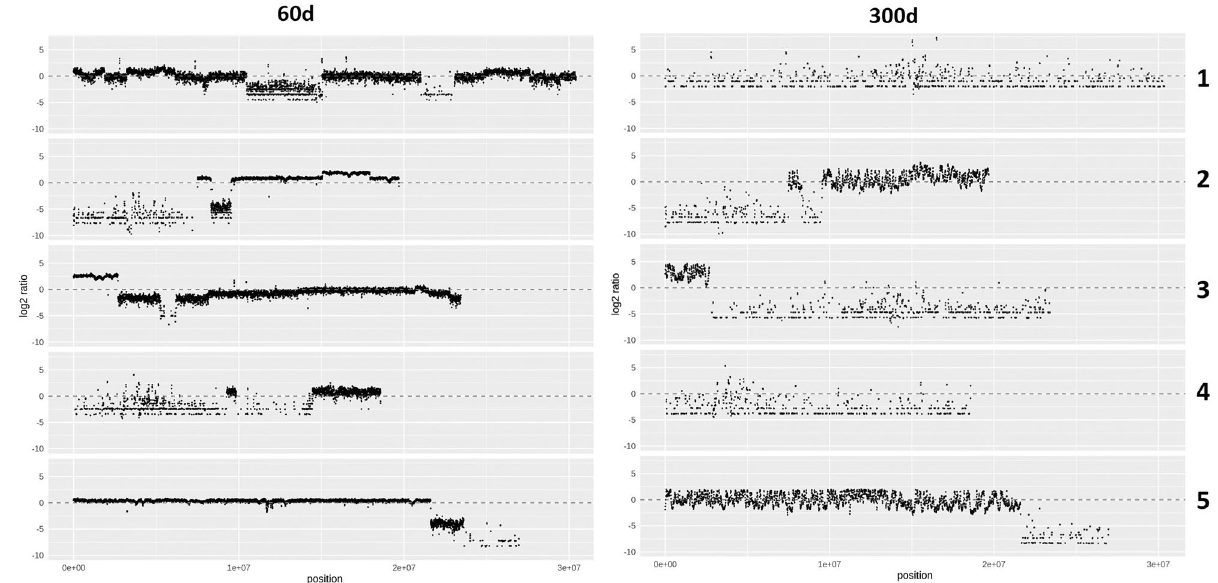
Figure 2. Copy number variation of Arabidopsis genome fragments in the 60- and 300-day-old hybrid cell lines. Log2 ratio of zero (gray dashed line) indicates diploid level. X-axis: DNA sequence of Arabidopsis pseudomolecules; Y-axis: log2 ratio relative to the Arabidopsis reference genome TAIR10. Numbers on the right side of the graphs indicate Arabidopsis chromosome numbers. Differences in plot density were caused by the adjustment of window size in CNV-seq according to coverage